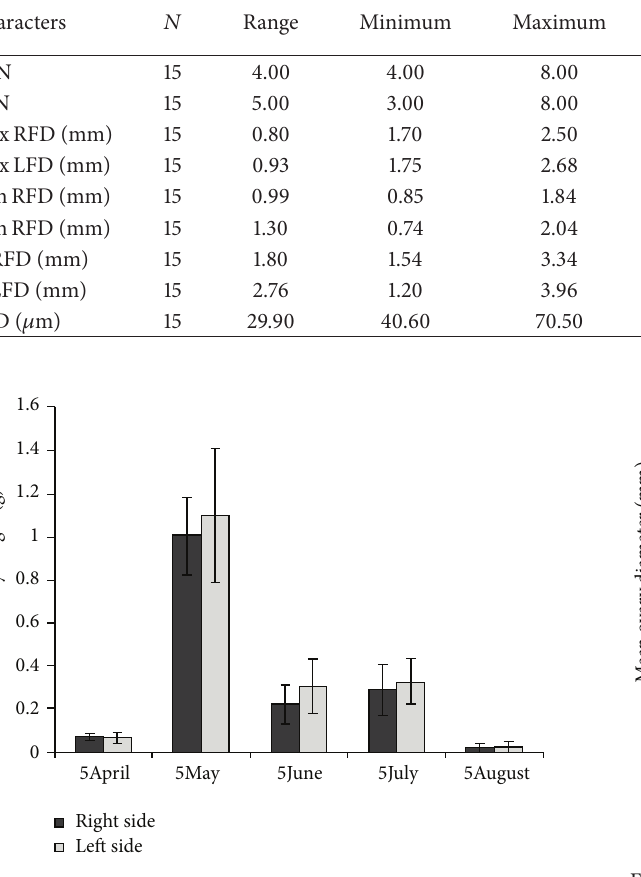
Figure 5: The mean ovary weight of Teratoscincus bedriagai .